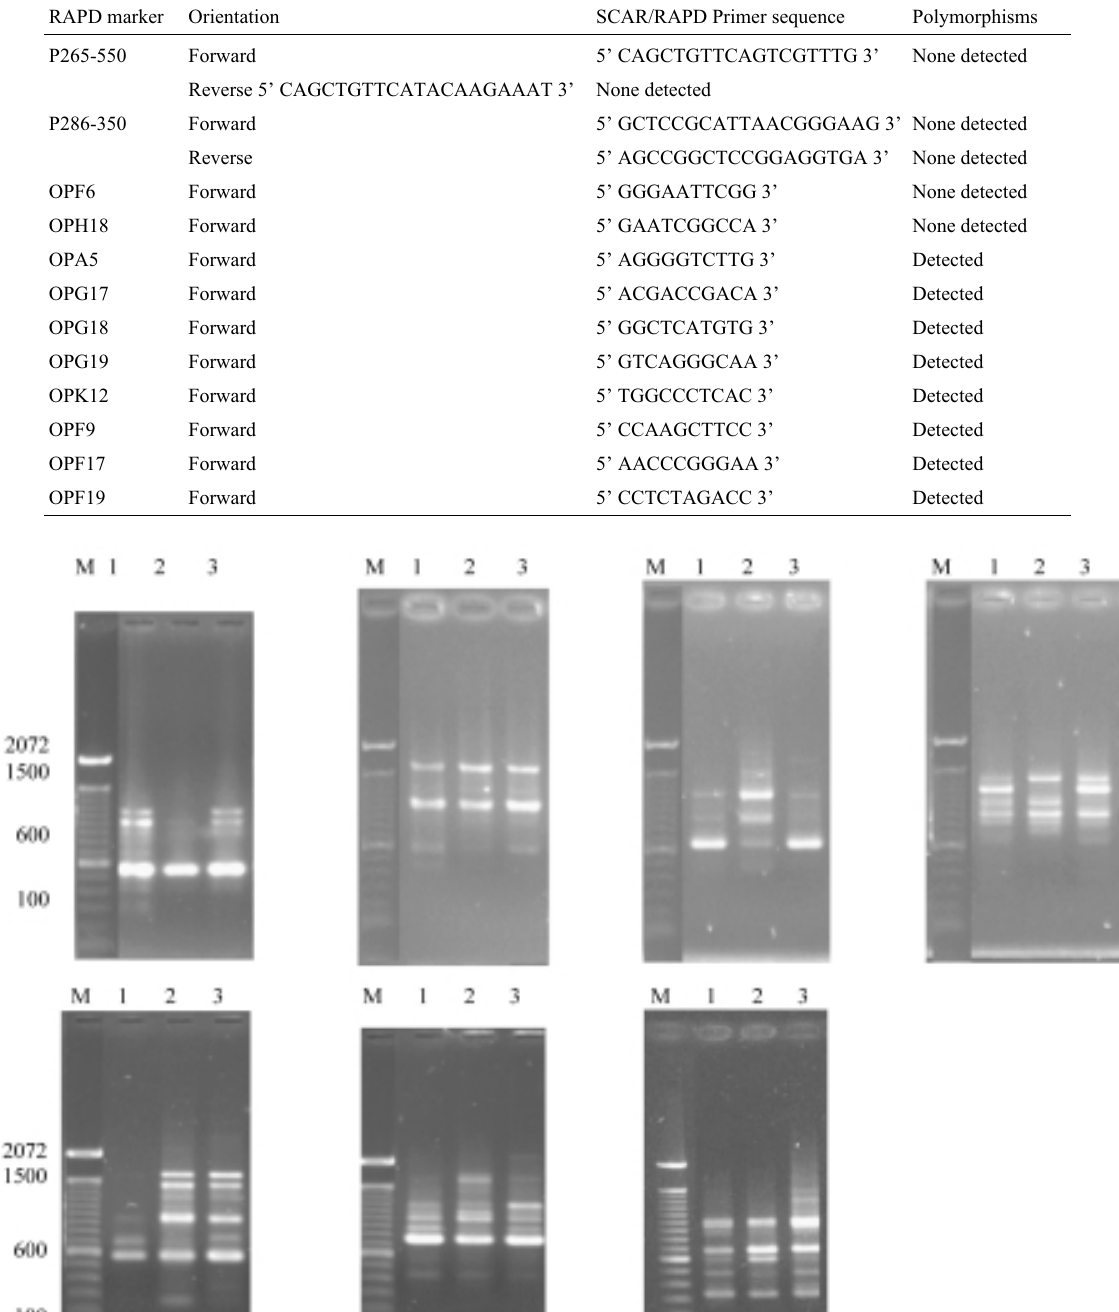
Table 1 - Nucleotide sequences of SCAR/RAPD markers for a rice-blast resistance